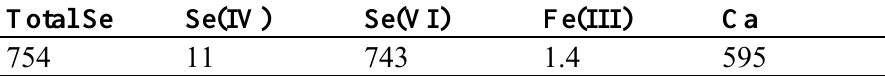
Table 1. Typical analysis of filtrate from the first stage (mg/L).